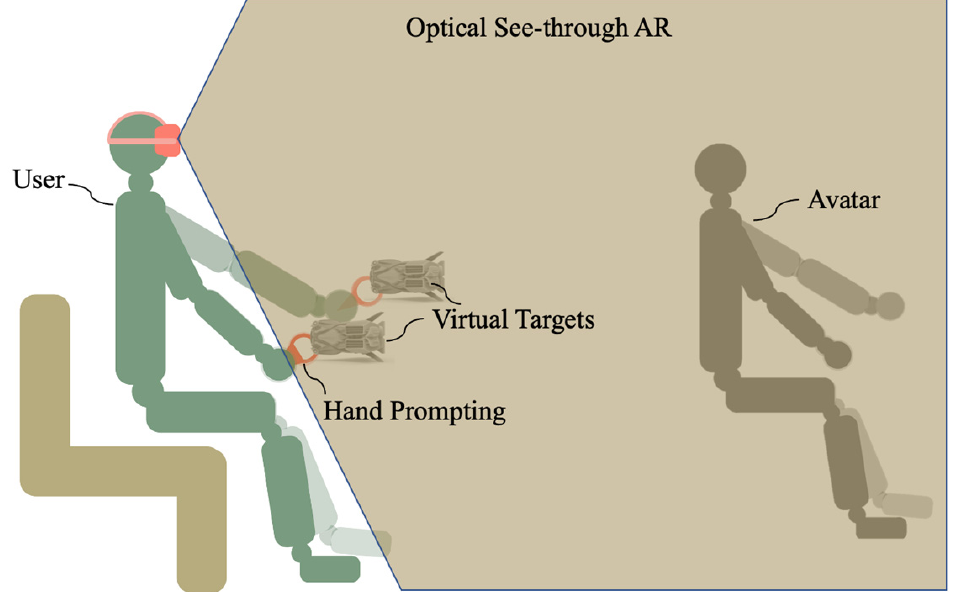
Figure 1. Tremor rehabilitation system using optical see-through AR.